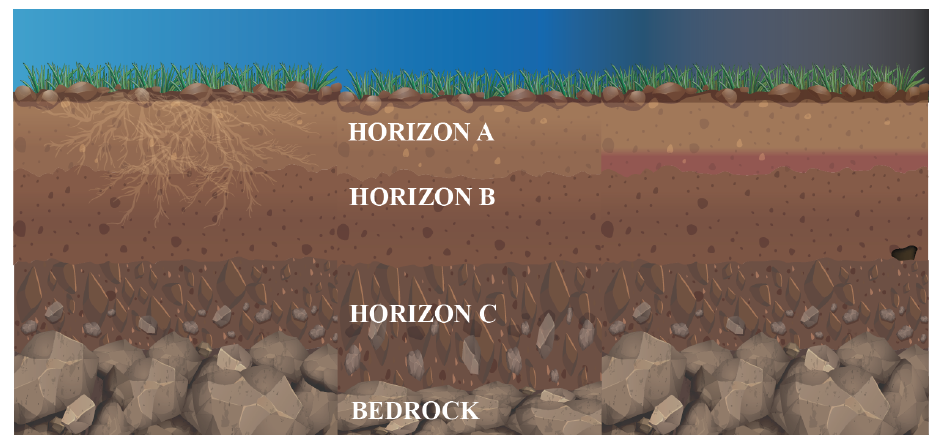
Figure 1. Scheme of the soil profiles surrounding an underground